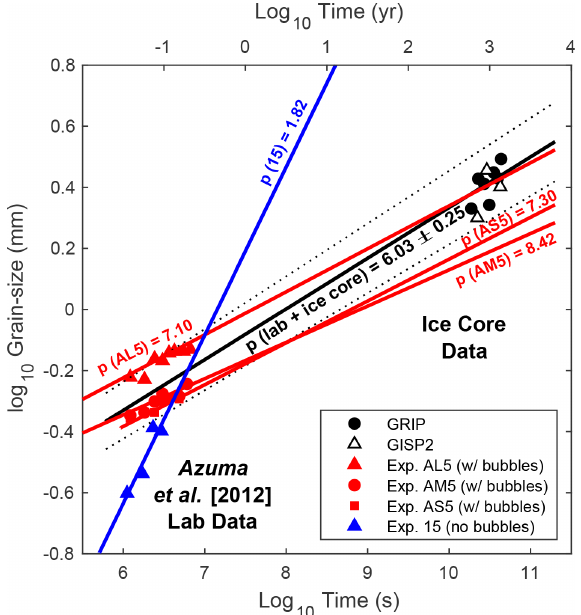
Figure 2. Comparison of grain growth rates derived from laboratory and ice core data. Data from individual laboratory experiments by Azuma et al. (2012) with and without bubbles are shown by red and blue symbols, respectively. Grain sizes for the GRIP (black circles; Thorsteinsson et al., 1997) and GISP2 (open triangles; Gow et al., 1997) ice cores are plotted as a function of time based on the age models of Dansgaard et al. (1993) and Ram et al. (2000), respec- tively. Only ice core data between 150–300m depth where grain growth dominates are used (see text). Red and blue curves show the fit to individual experiments conducted at a temperature equivalent to the ice core data (243K); grain growth exponents (labeled) are calculated following the methodology in Bons et al. (2001). The black curve shows the fit calculated using all three laboratory ex- periments that contain bubbles and the GRIP ice core data. Dotted black lines show the 1 σ error estimate on fit to lab and ice core